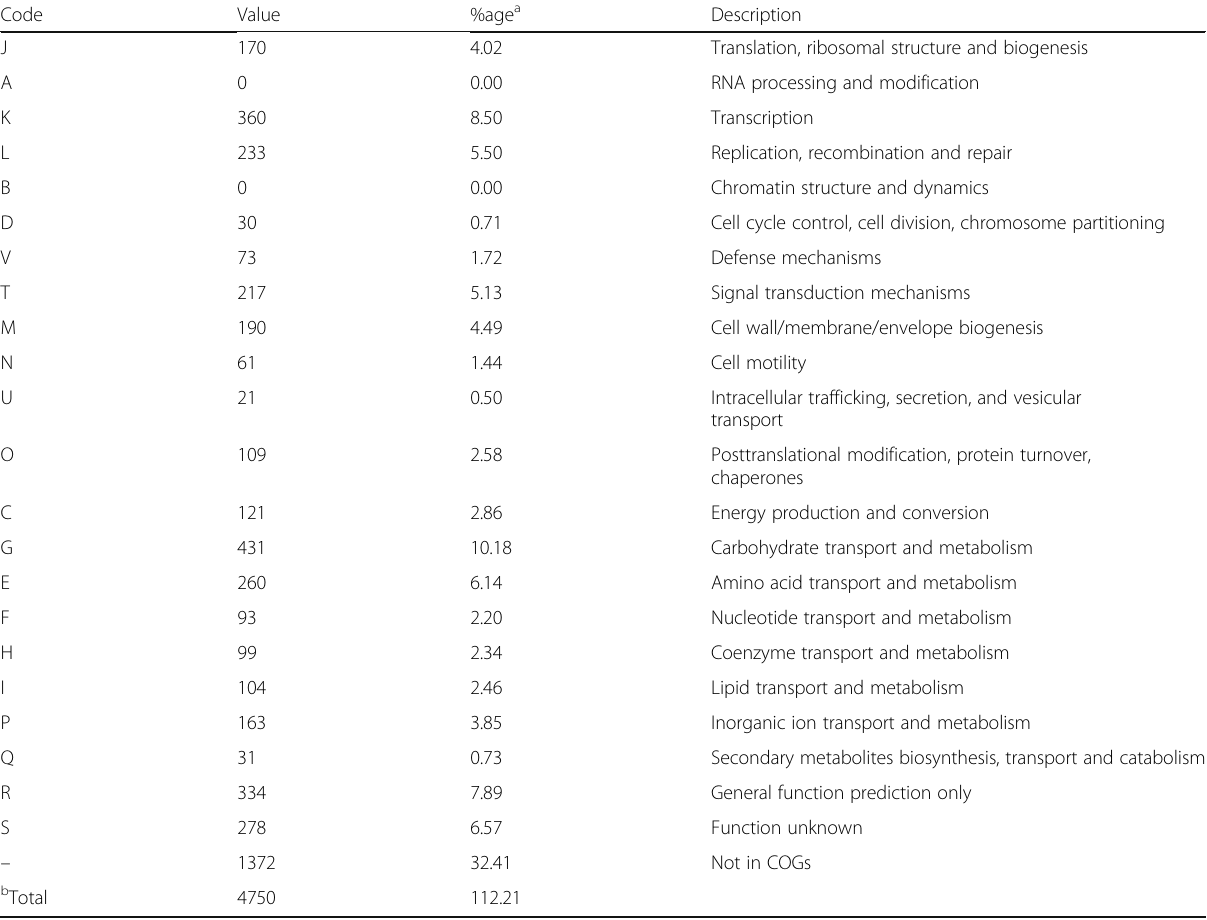
Table 3 Number of genes associated with the 22 general COG functional categories